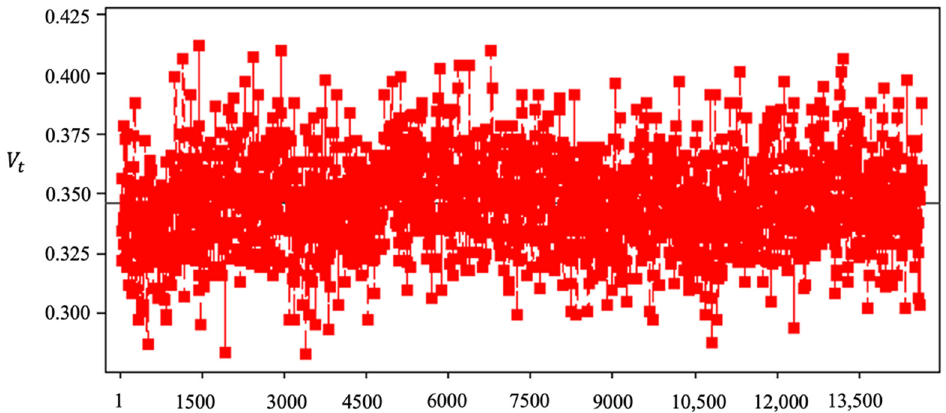
Figure 2. The run chart result for Vt values.